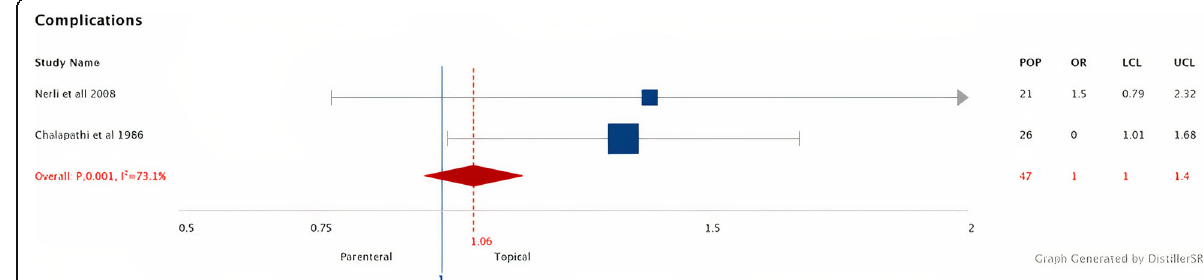
Fig. 8 Forest plot of complication of testosterone